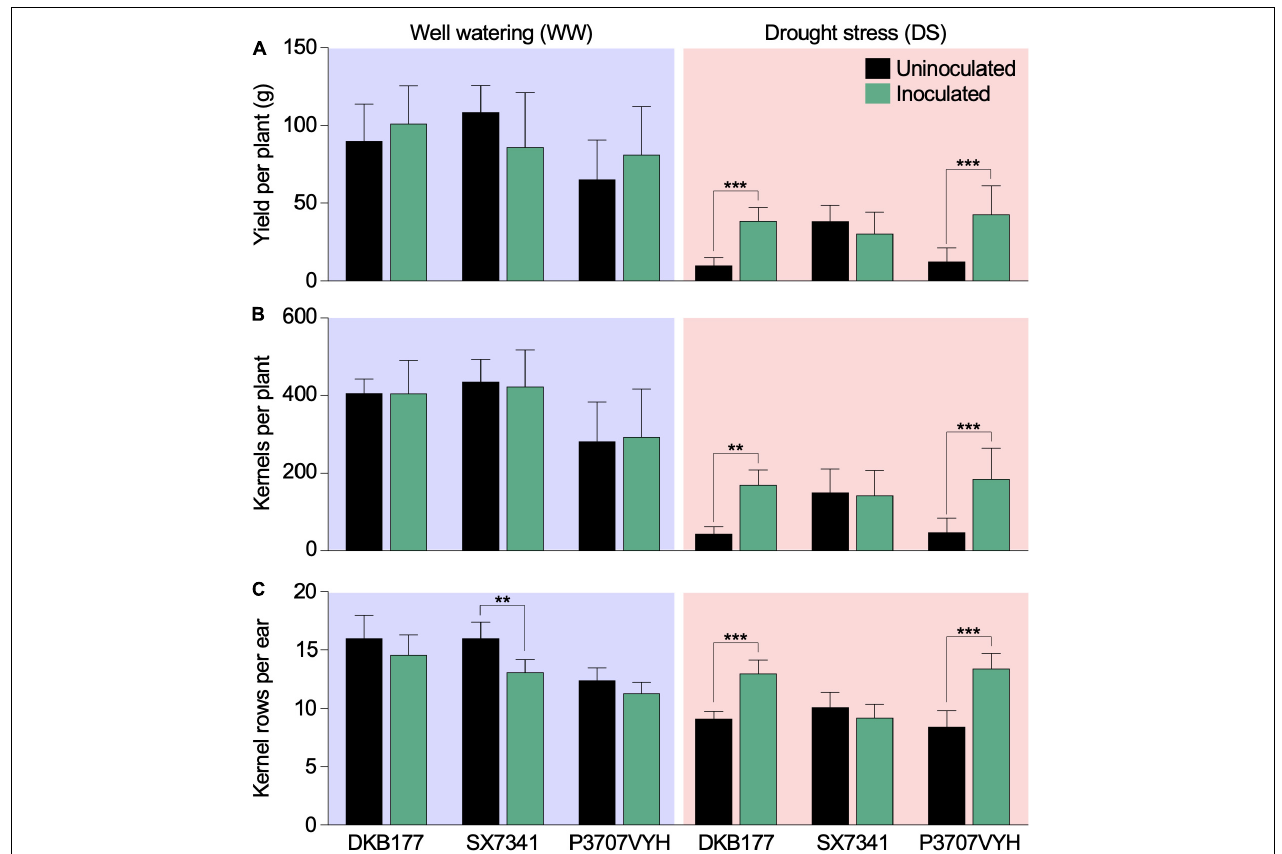
FIGURE 2 | Synthetic community (SynCom) inoculation reduces the yield loss of commercial maize hybrids under DS. During DS, inoculated DKB177 and P3707VYH plants displayed higher (A) yield per plant (3.93 × and 3.45 × , respectively), (B) number of kernels per plant (3.87 × and 3.85 × , in that same order) and (C) number of kernel rows per ear (42 and 59%, respectively) under DS. Additional yield results are shown in Supplementary Figure 5 . Values expressed as the mean ± SD. n ≥ 7 plants per treatment. WW, well watering; DS, drought stress; SD, standard deviation. ** P ≤ 0.01 and *** P ≤